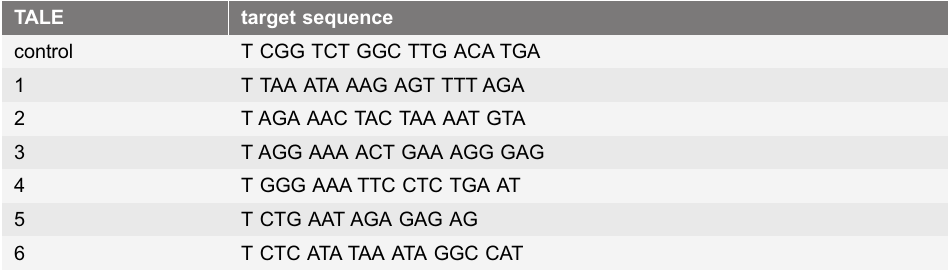
Table 1. TALE binding sites within the IFN-beta promoter (see also Fig. 1A).